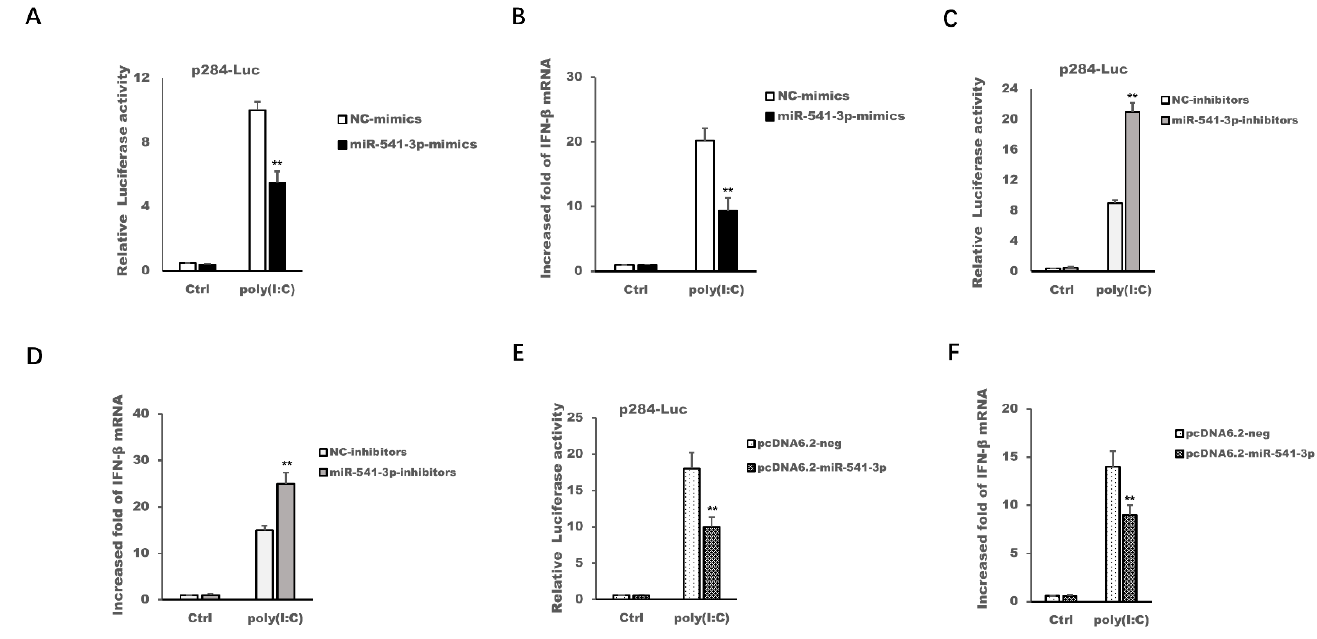
Figure 3. miR-541-3p inhibited poly(I:C)-induced production of type I interferon. MARC-145 cells were transfected with p-284, pRL-TK and miR-541-3p mimics ( A ), miR-541-3p inhibitors ( C ) or pcDNA6.2-miR-541-3p ( E ), and 36 h later, the cells were transfected with poly(I:C) (10 µ g/mL), and 9 h later, the IFN- β luciferase activities were assayed by using the dual-luciferase reporter assay. MARC-145 cells were transfected with miR-541-3p mimics ( B ), miR-541-3p inhibitors ( D ) or pcDNA6.2-miR-541-3p ( F ), and 36 h later, the cells were transfected with poly(I:C) (10 µ g/mL), and 9 h later, the mRNA expression levels of IFN- β were assayed by quantitative real time polymerase chain reaction (qRT-PCR). Ctrl indicated that the cells were not transfected with poly(I:C). All experiments were repeated at least three times with similar results. ** p <